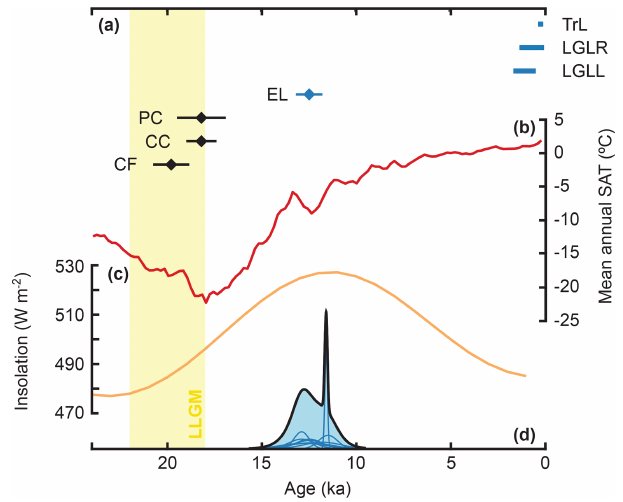
Figure 5. LGM, Deglacial, and Holocene periods; diamonds in- dicate moraine ages. (a) Blue diamonds are ages from this study. Blue bars represent the age range for late-Holocene samples. TrL stands for Triangle Lake, LGLL stands for Little Glacier Lake left- lateral moraine, and LGLO stands for Little Glacier Lake right lat- eral moraine. Black diamonds are ages from Licciardi and Pierce (2018). PC stands for Pine Creek moraine, CC stands for Crandall Creek, and CF stands for Clarks Fork. (b) The red line is the mean annual surface temperature for our study area taken from Osman et al. (2021). (c) The orange line is mean annual insolation for 45 ◦ N. (d) Bottom probability distribution shaded in blue is for the compi- lation of western US Younger Dryas moraines taken from Marcott et al. (2019), Licciardi and Pierce (2018), and the Emerald Lake moraine from this study. The yellow box highlights the timing of the local LGM from 22 to